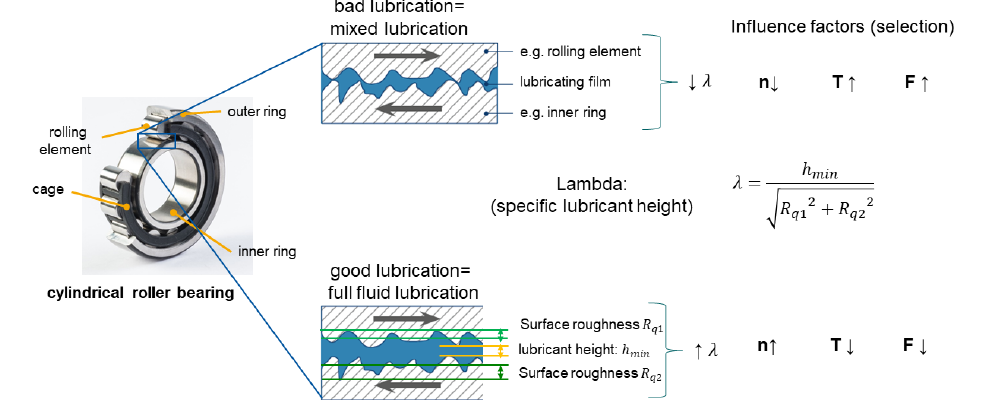
Figure 6. Brief explanation of the lubrication state and the influence factors.